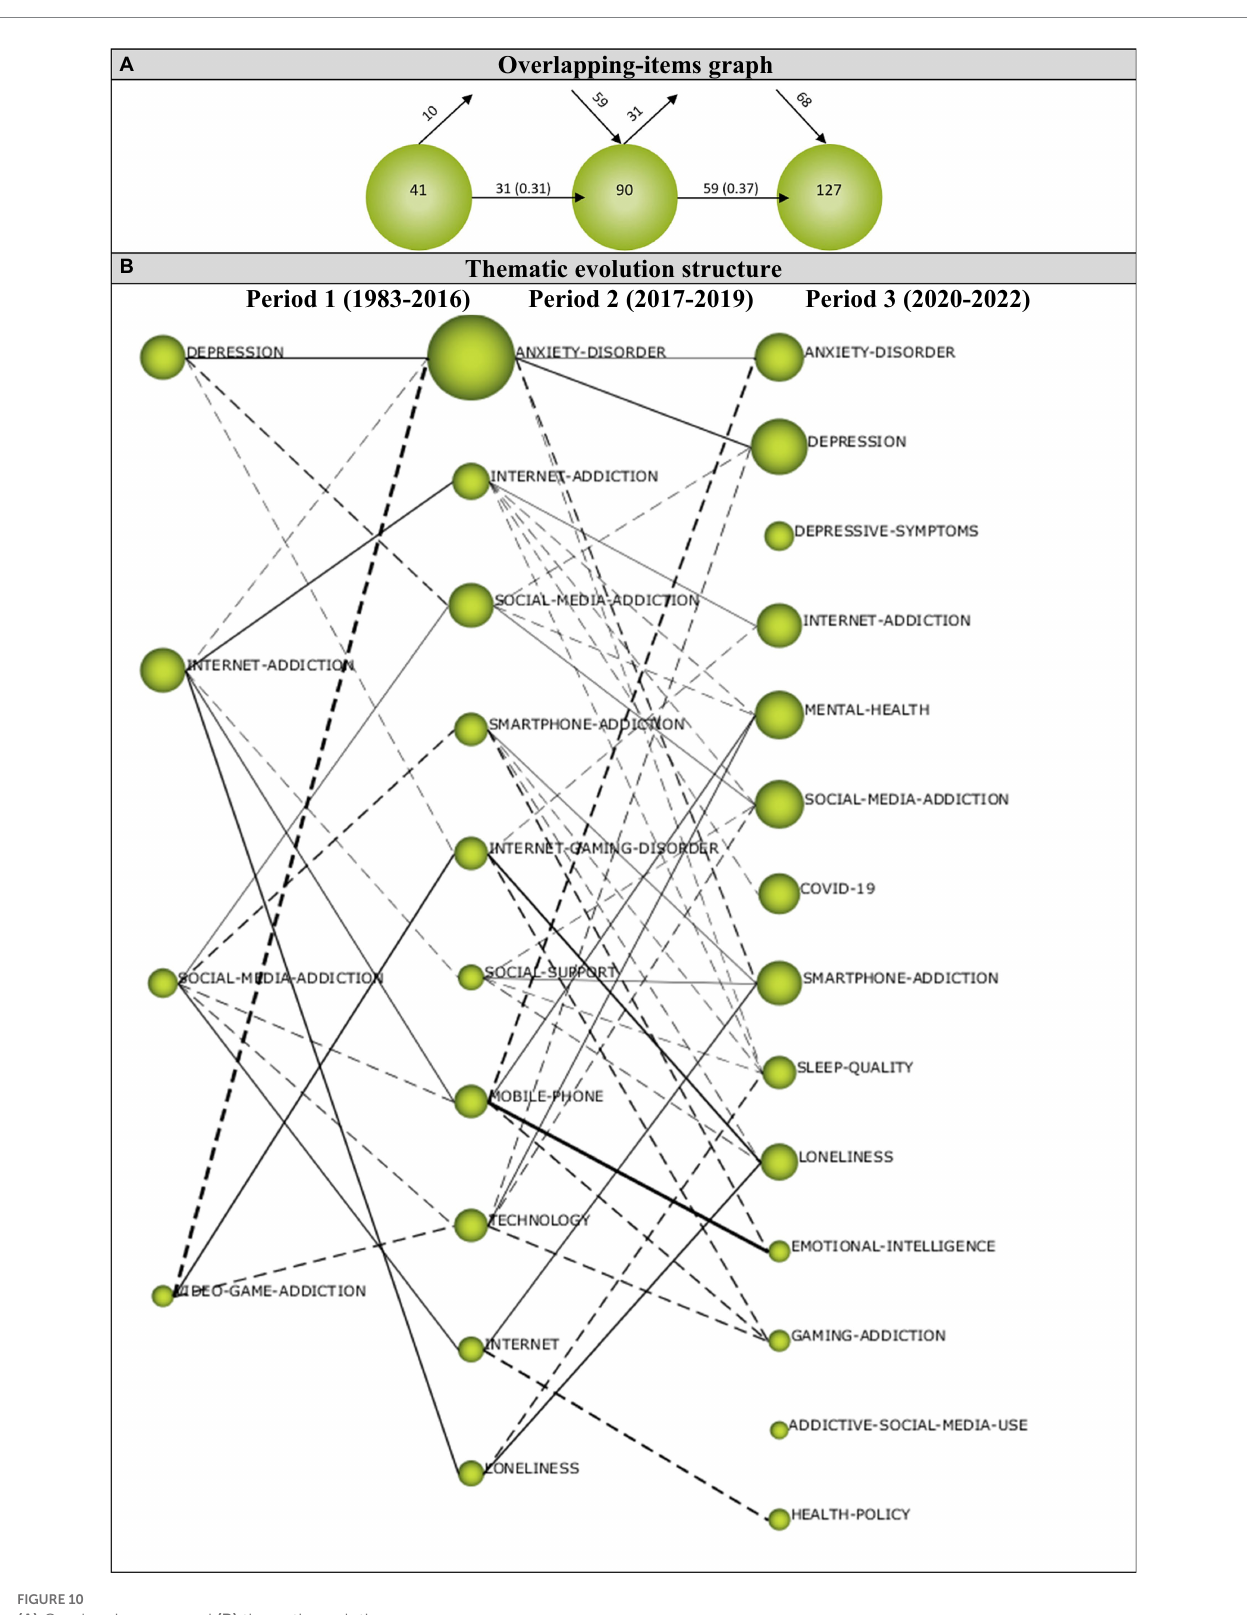
FIGURE 10 (A) Overlapping map and (B) thematic evolution